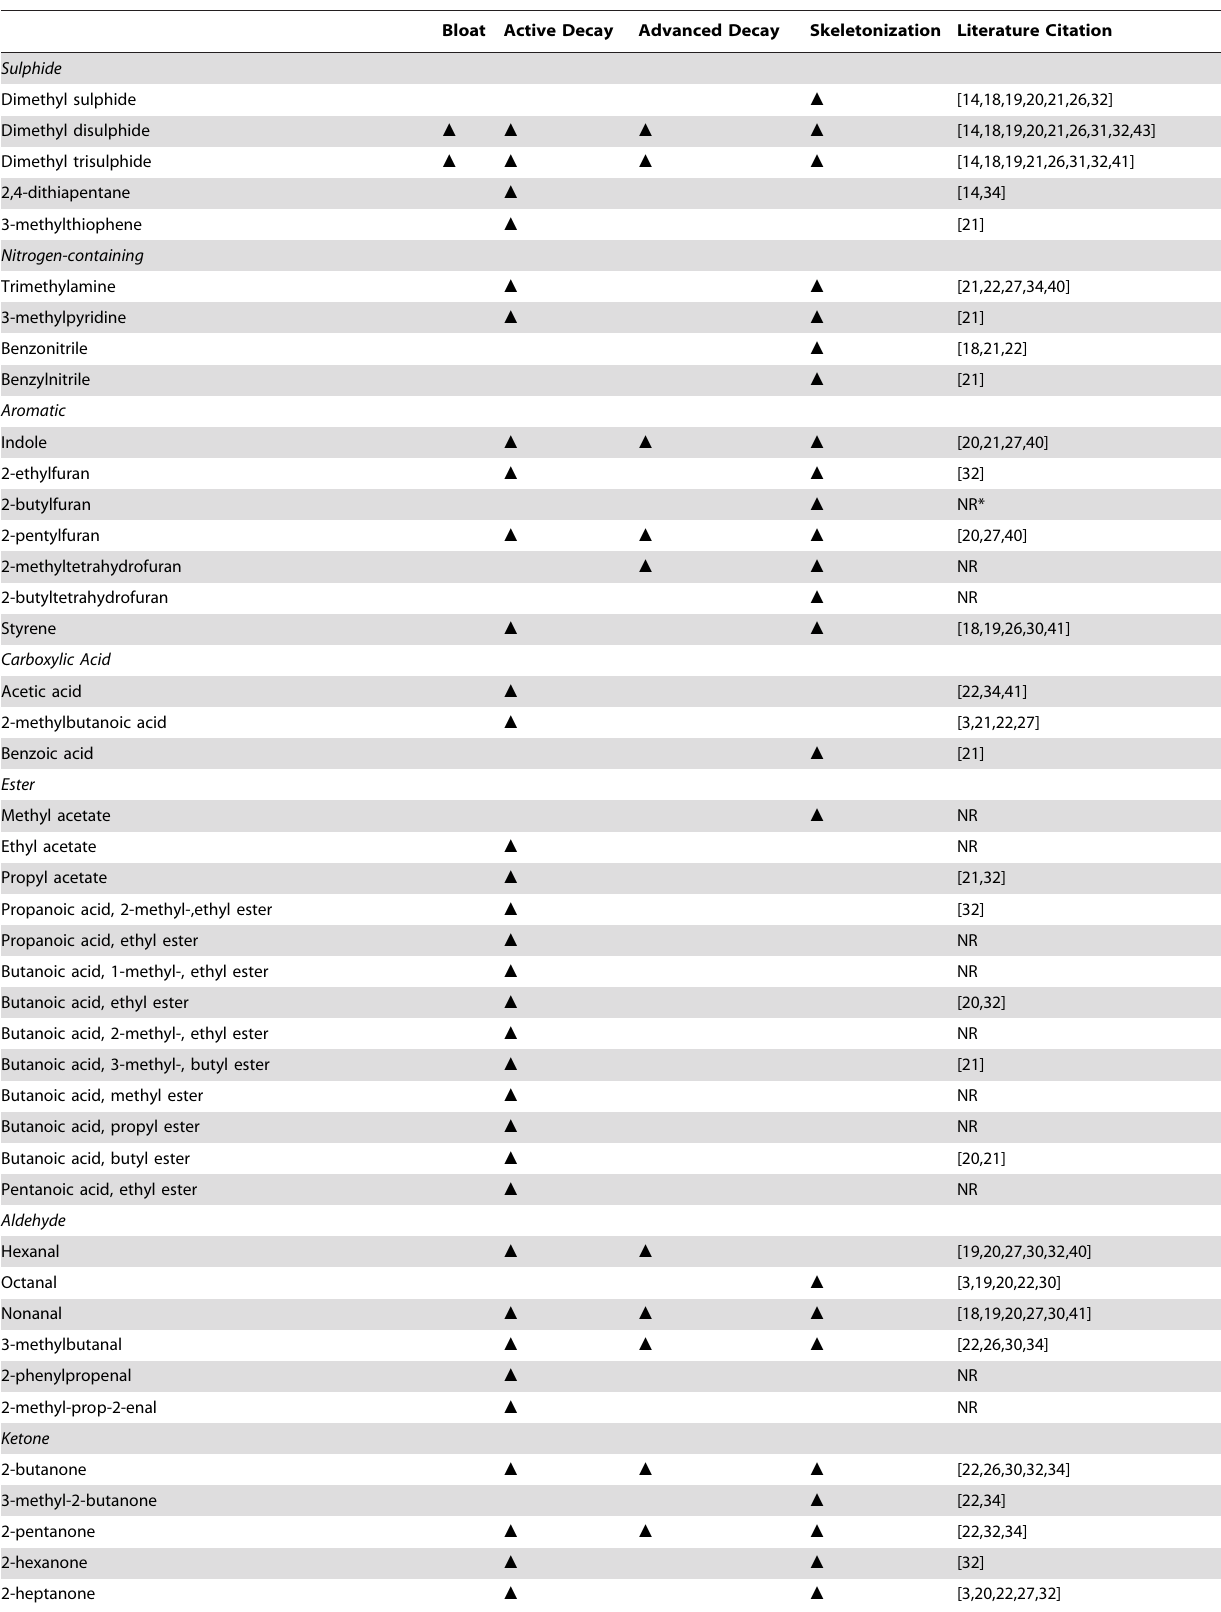
Table 2. Major VOCs consistently identified in experimental soil samples throughout the decomposition stages (excluding